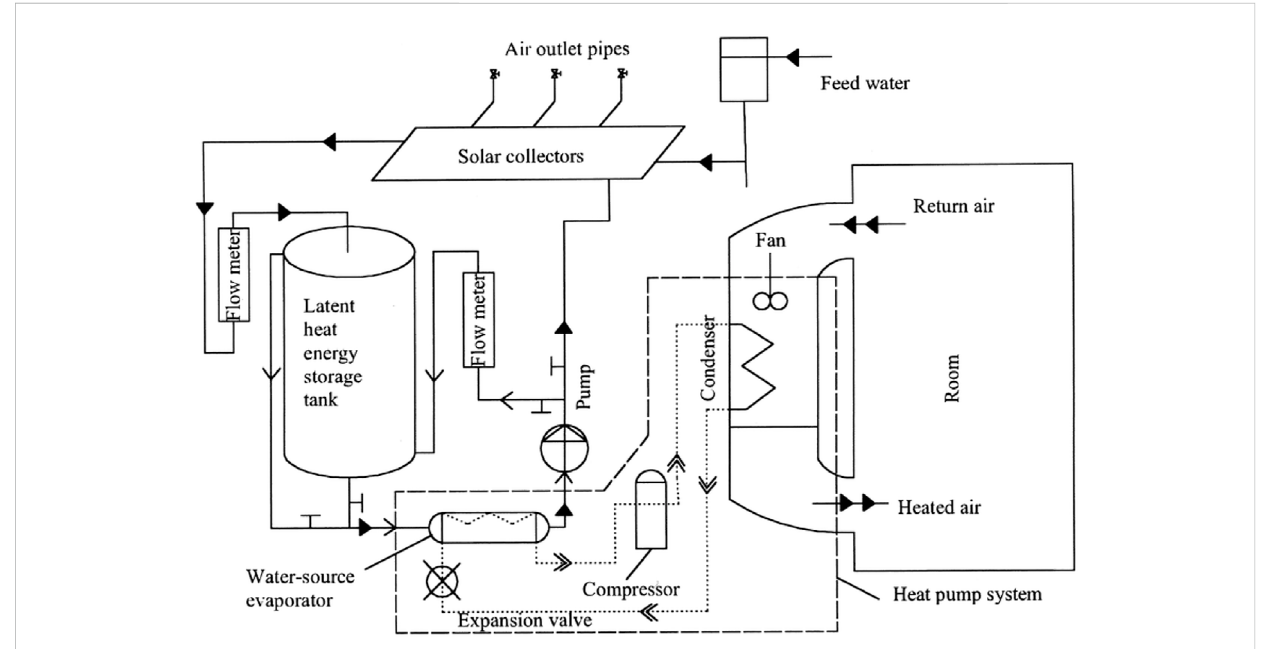
FIGURE 4 Latent heat energy storage technique (Source: latent heat storage TANK —